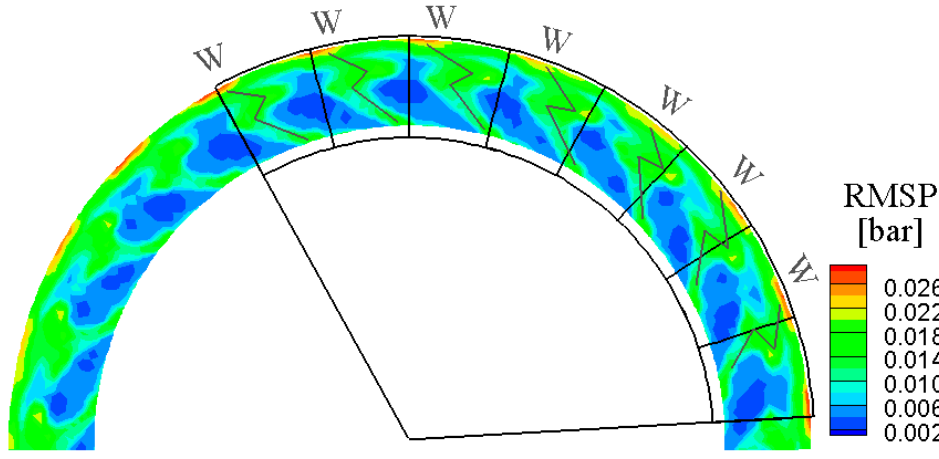
Figure 8. Snapshot of RMSP distribution over multiple channels in different stator–rotor positions.